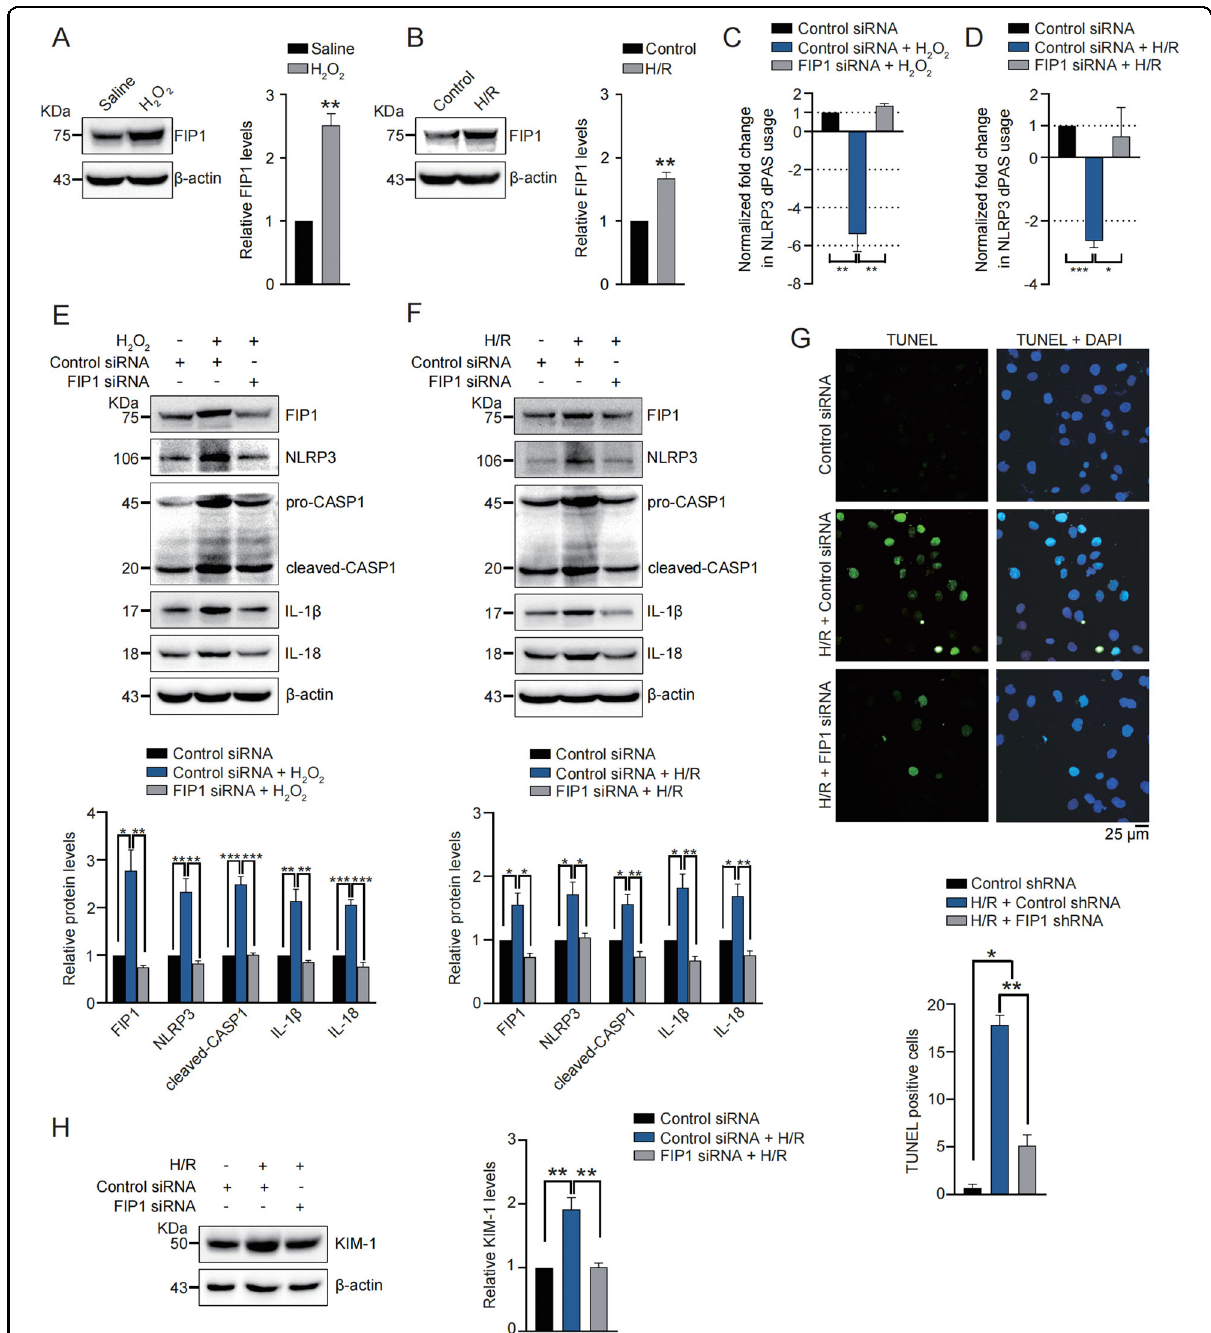
Fig. 6 FIP1 is upregulated by oxidative stress and required for oxidative stress-induced NLRP3 upregulation, in fl ammation, apoptosis, and cell damage. A Western blot was performed and quantitatively analyzed to determine the protein levels of FIP1 in HK2 cells treated with saline or H 2 O 2 (0.5 mM). B Western blot was performed and quantitatively analyzed to determine the protein levels of FIP1 in HK2 cells treated with H/R. C , D qRT-PCR was performed to determine the normalized fold changes of distal PAS usage of NLRP3 in HK2 cells with indicated treatment. E , F Western blot was performed and quantitatively analyzed to determine the protein levels of FIP1, NLRP3, caspase1, IL-1 β , and IL-18 in HK2 cells with indicated treatment. G Representative images and quantitative analysis of TUNEL staining in HK2 cells with indicated treatment. H Western blot was performed and quantitatively analyzed to determine the protein levels of KIM-1 in HK2 cells with indicated treatment. * P < 0.05; ** P < 0.01; *** P < 0.001; All data represent the mean ± SEM obtained from three independent experiments. Student ’ s t